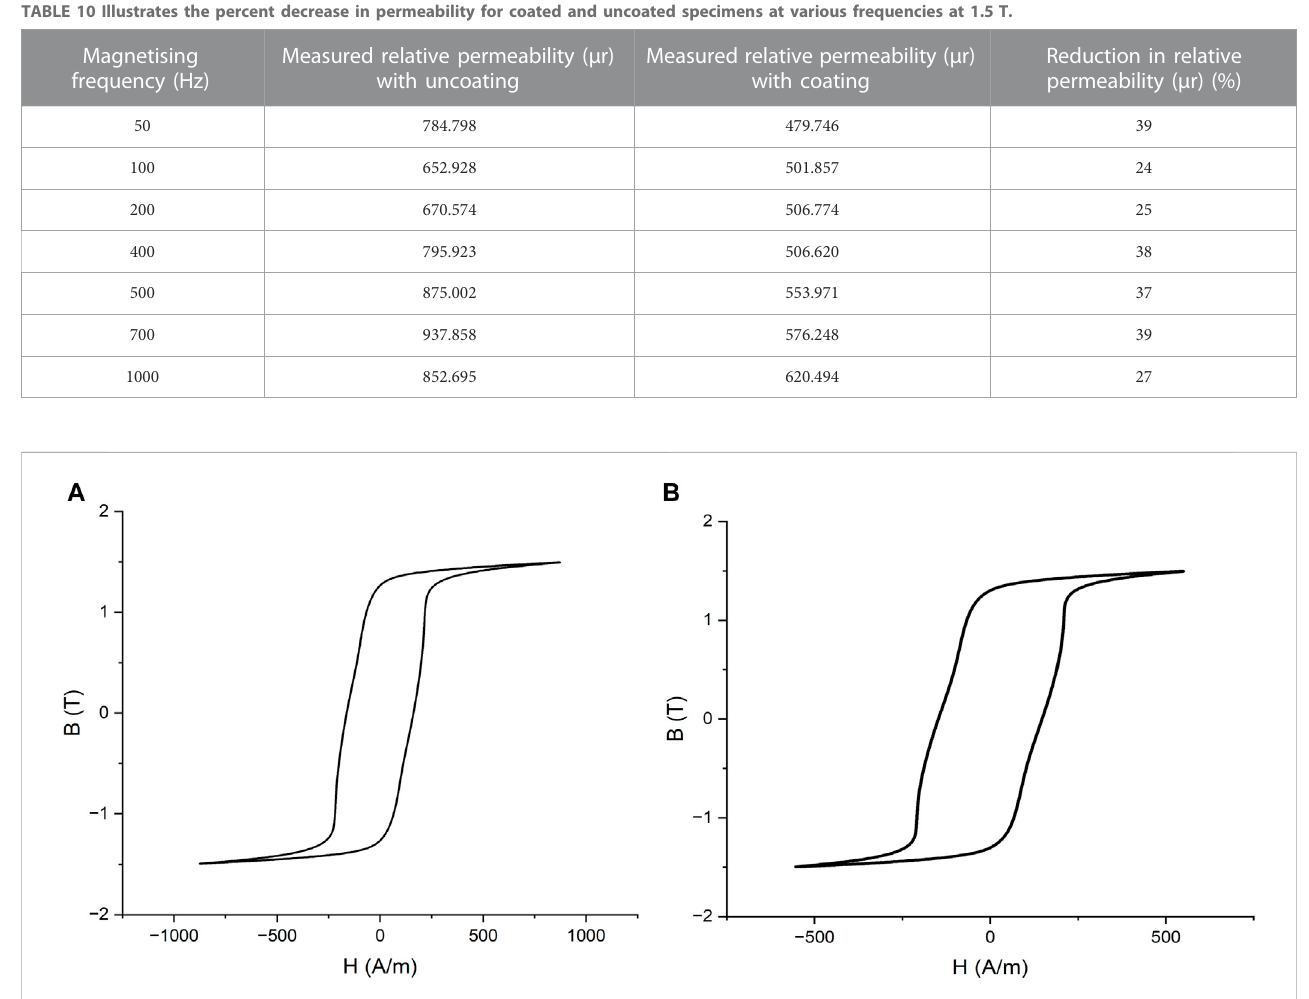
FIGURE 11 The hysteresis loop at 500 Hz and 1.5 T (A) Uncoated sample, (B) coated